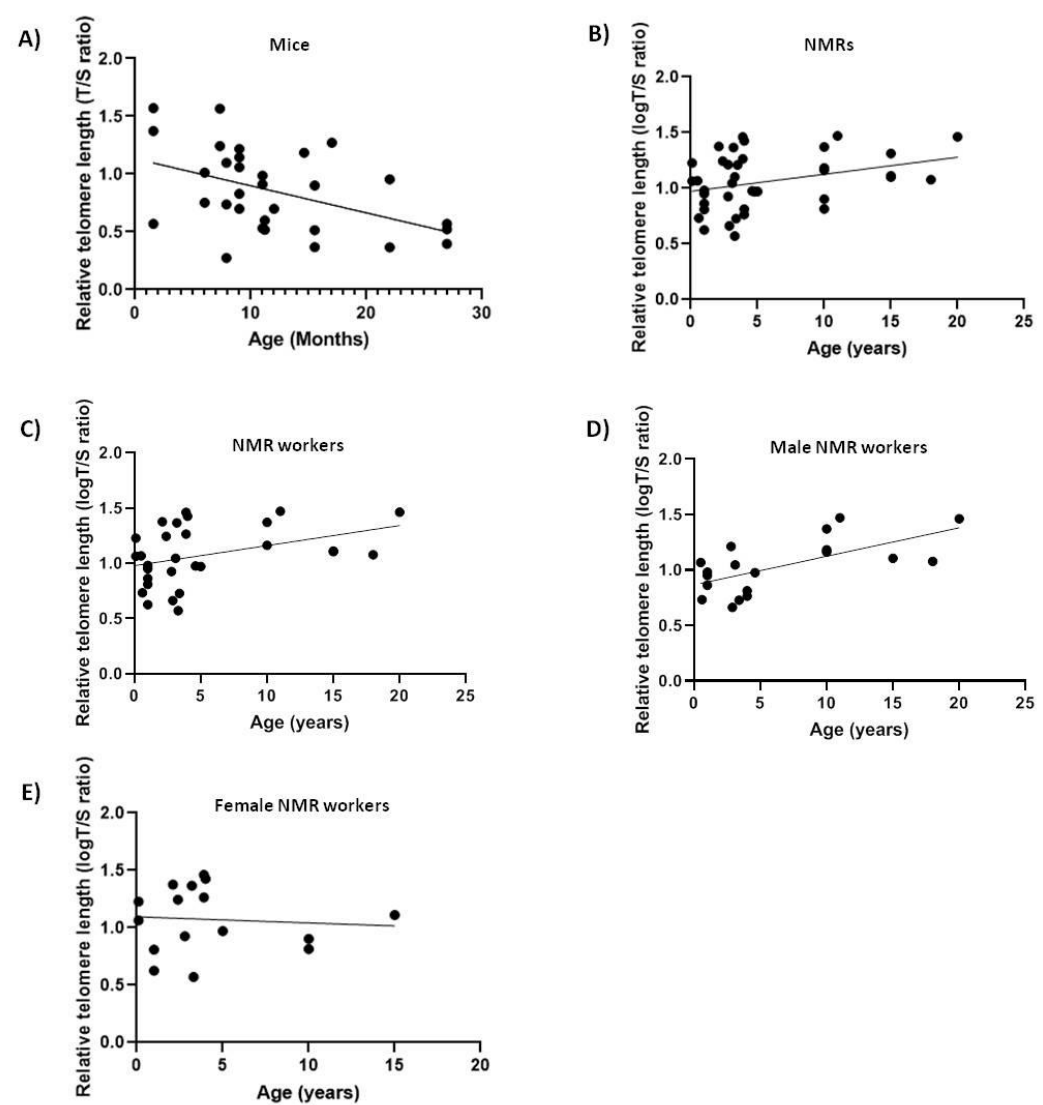
Figure 1. Relative telomere length (Telomere to Single copy gene (T / S) ratio) as a function of age in naked mole-rats (NMRs) and mice blood. The lines are the best-fit regressions through the data in ( A ) mice (slope = − 0.02343, F 1,29 = 7.741, p < 0.01, R 2 = 0.2107); ( B ) NMRs (slope = + 0.01538, F 1,38 = 4.9691, p < 0.05, R 2 = 0.1156); ( C ) NMR workers (slope = + 0.01817, F 1,27 = 4.672, p < 0.05, R 2 = 0.1475); ( D ) male NMR workers (slope = + 0.02571, F 1,17 = 12.3, p < 0.05, R 2 = 0.4197); ( E ) female NMR workers (not significant (ns)).